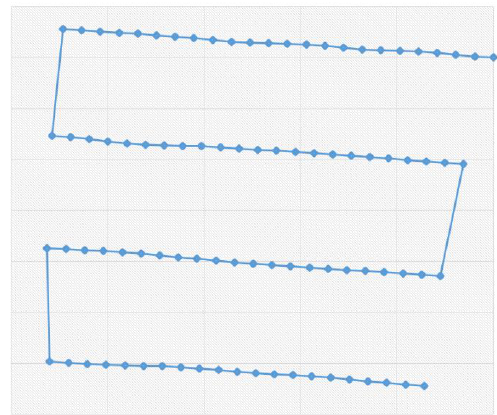
Figure 5. The simulated Movement trajectory